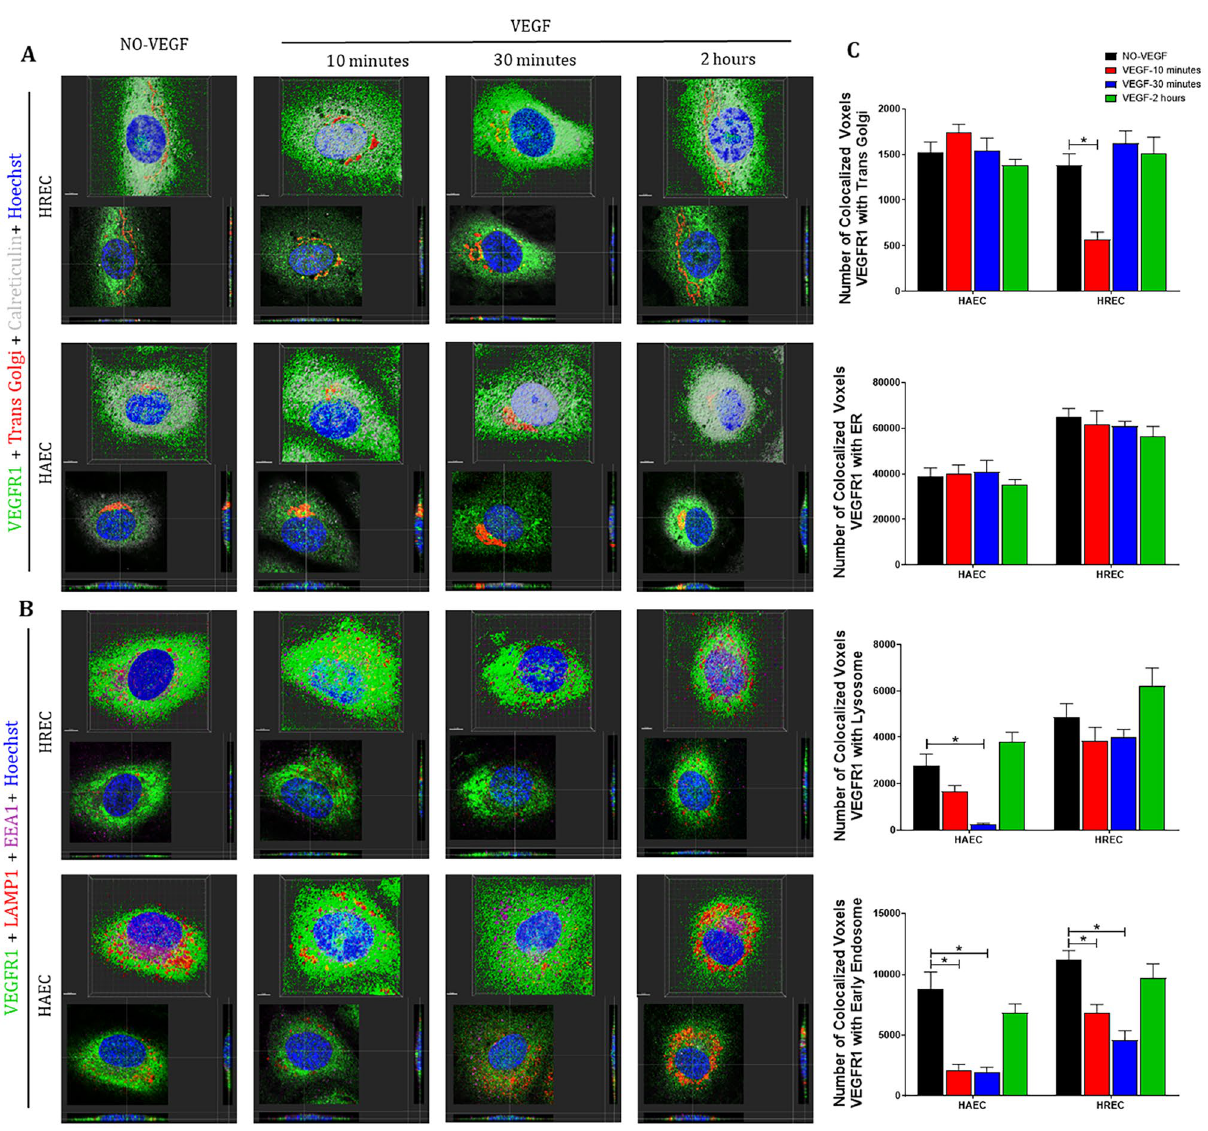
Figure 4. VEGFR1 translocates from intracellular compartments to the nucleus after VEGF treatment of endothelial cells . Intracellular trafficking of VEGFR1 in HREC and HAEC were evaluated by immunofluorescence at different time points (10 min, 30 min and 2 h) after exposure to 100 ng/ml VEGF and compared to saline controls (NO-VEGF). Triple immunofluorescence was performed to colocalize VEGFR1 with specific organelles. ( A ) 3D reconstruction rendering of the HREC and HAEC immunostained with VEGFR1 (green), trans Golgi (red) and calreticulin (endoplasmic reticulum-ER gray) ( B ) 3D reconstruction rendering of HREC and HAEC immunostained with VEGFR1 (green), LAMP1 (lysosome-red) and EEA1 (early endosome-magenta). The nuclei in ( A ) and ( B ) were fluorescently stained with the DNA intercalating dye Hoechst (blue). The colocalization points between green and red are shown in yellow and between green and magenta shown in gray. The top image of each block shows the 3D rendering of the representative cells at each time point and the same cells are shown in the lower image of each block showing the position of the nuclear translocation of VEGFR1 in only one focal plane in the center and the correlation of this point located in the 3D lateral and lower cross sections. Scale bars = 5 μm. ( C ) Quantification of the number of VEGFR1 colocalized voxels with the organelles relative to the number of cells in each image. The results show the analyzes of at least 10 confocal z-stack images at 400 × magnification for each time point by Imaris software and summarize the data obtained by quantifying the organelles from a minimum of 3 separate experiments from 3 donors of the HREC and 2 donors of the HAEC. The results show that the colocalization of VEGFR1 with trans Golgi, early endosomes and lysosomes decrease between 10 and 30 min after VEGF treatment, which correlates with the increase of this receptor in the nucleus during the same period. * = p < 0.05 as determined by 1-way ANOVA and multi-comparison post-hoc Tukey’s test is considered